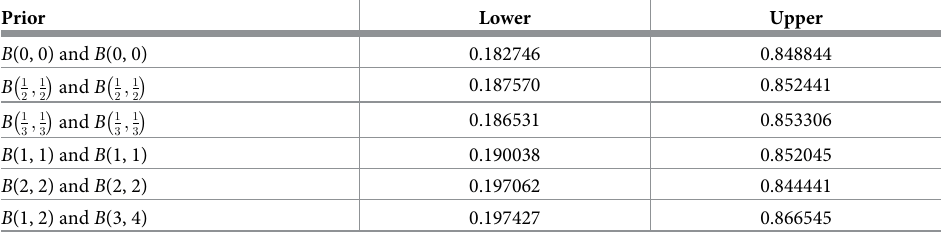
Table 6. 95% highest posterior density credible intervals for the Black Death plague data from Table 2 for various priors. Prior Lower Upper B (0, 0) and B (0, 0) 0.182746